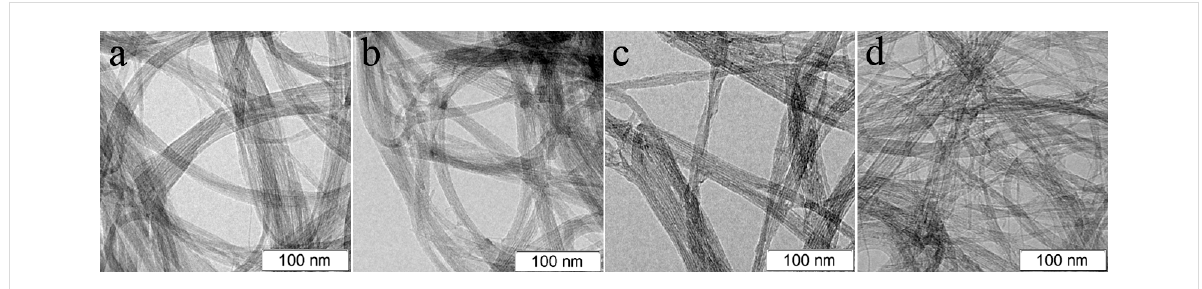
Figure 2: TEM images of pristine purified DWCNTs (a) and DWCNTs fluorinated with CF 4 plasma (b), BrF 3 (c), and F 2 (d).